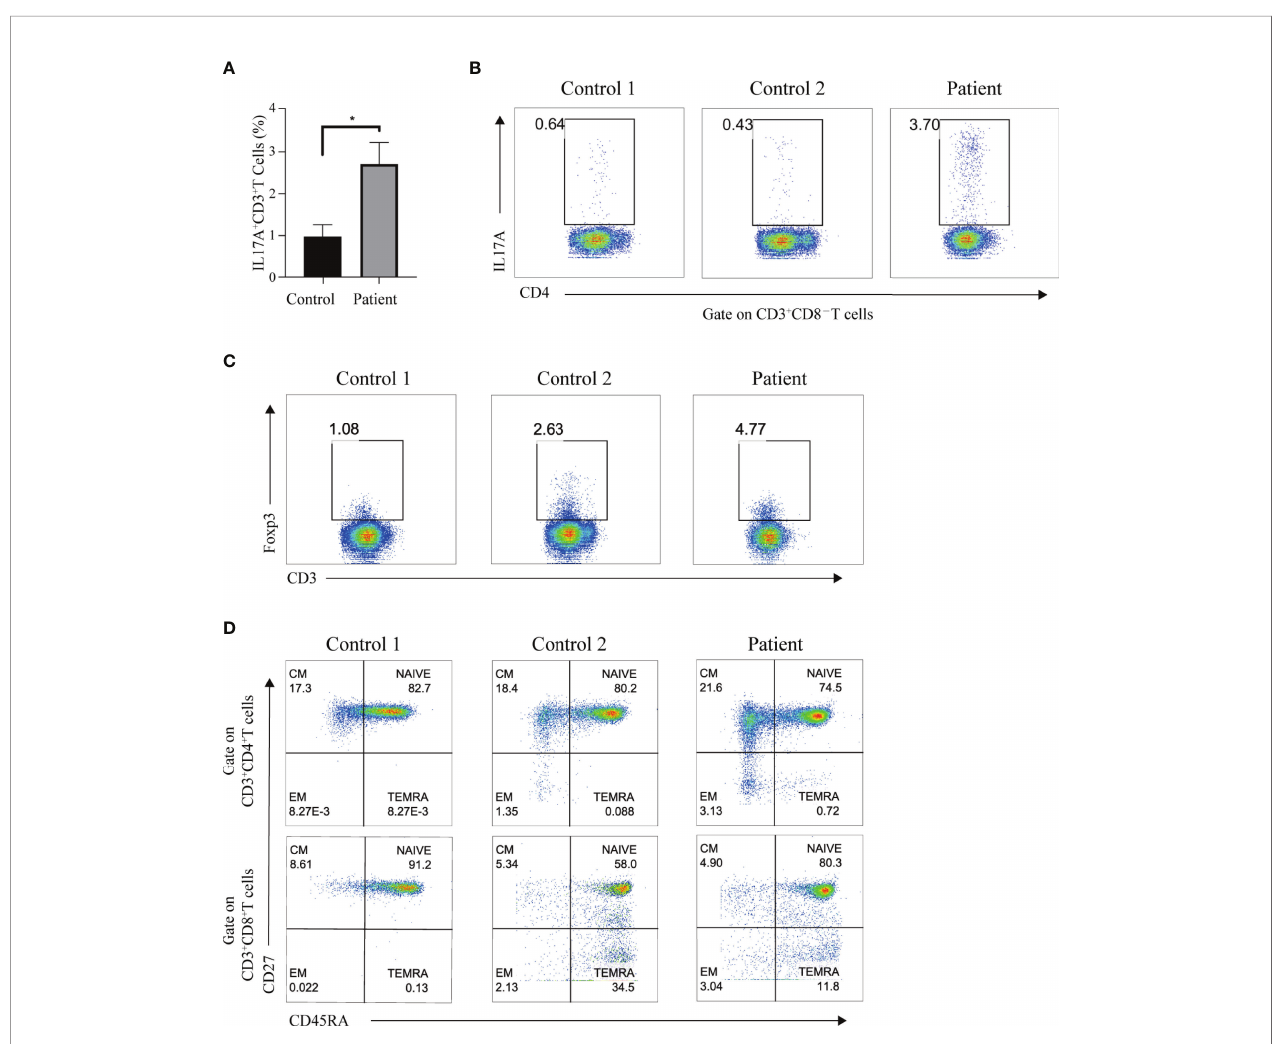
FIGURE 4 | The Th17 cells and immune-phenotype in the patient. (A) The black and grey bars indicate the percentage of Th17 cells, as determined by fl ow cytometry, in phorbol myristate acetate (PMA)/ionomycin-activated PBMCs of the patient and healthy controls, respectively. Data are expressed as mean±SEM. * p < 0.05. (B) The IL-17A production in T cells of the patient and two healthy controls after PMA/ionomycin treatment. (C) The representative dot plot shows the Treg population in the patient and two healthy controls, respectively. (D) Flow cytometry plots show the naive, central memory (CM), effector memory (EM), and terminally differentiated effector memory (TEMRA) CD4 or CD8 subpopulations in the patient and two age-matched healthy